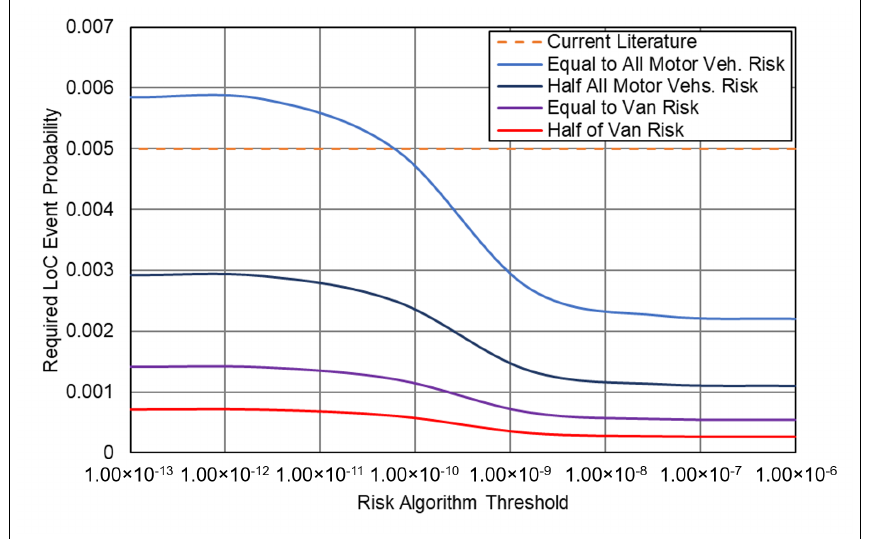
Figure 8. Target drone LoC event probabilities to be equal to ground transportation risk levels. Half = Half of the Fatality Rate/Twice as Safe.